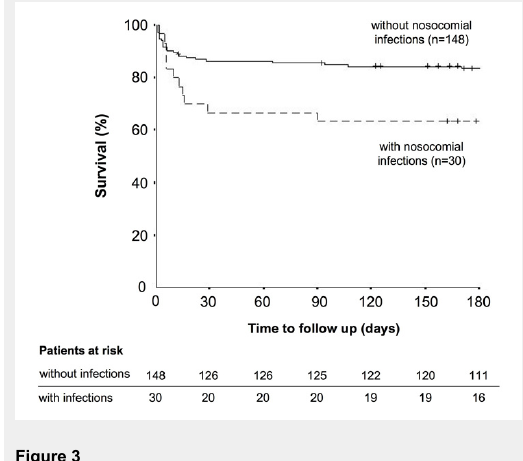
The curves show survival rates over time for acute heart failure patients with (dashed line, n = 30) and without (straight line, n = 148) infectious complications during their ICU stay (Log rank p = 0.02). The small vertical lines indicate the time points when a patient had his latest follow up. In addition, the numbers of patients at risk are tabulated for the main intervals of the rate of survival